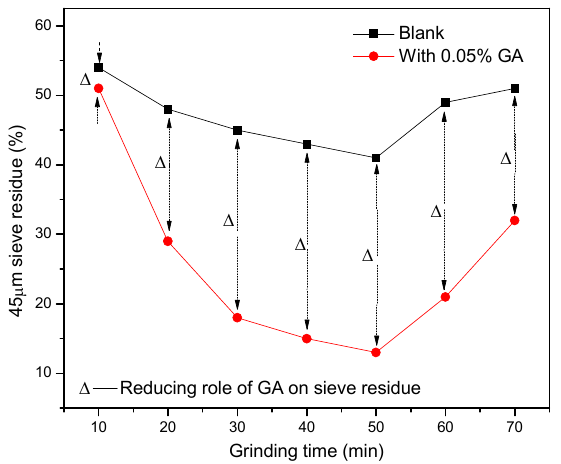
Figure 9. Sieving residue of steel slag powder with grinding aid (GA) vs. grinding time.